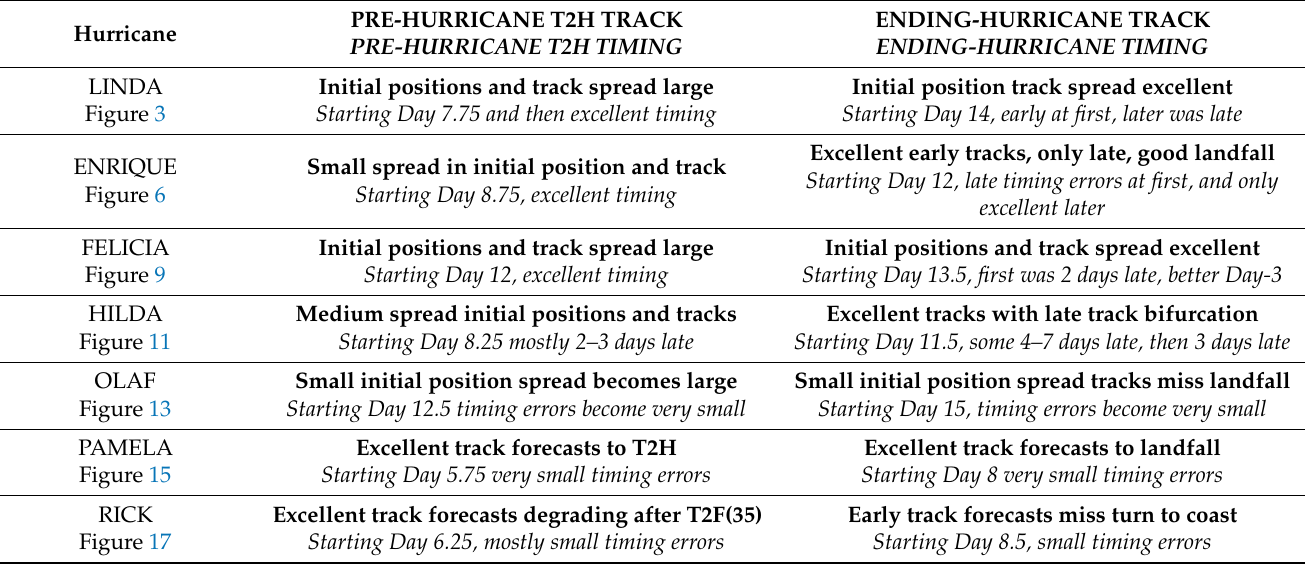
Table 6. Characterizations of ECEPS track and timing performance for pre-T2H and ending-T2H lifecycle periods.